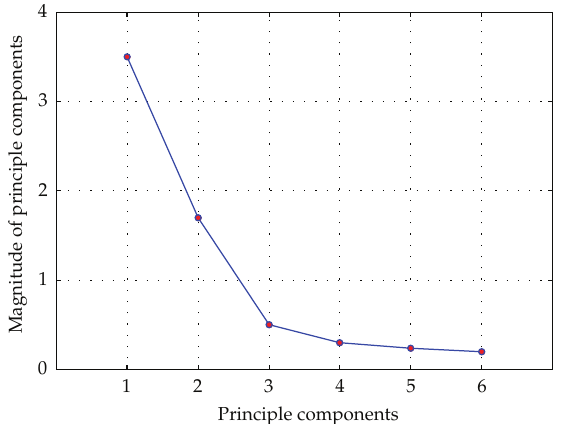
Figure 2: An example of a screen plot showing the principle components and its